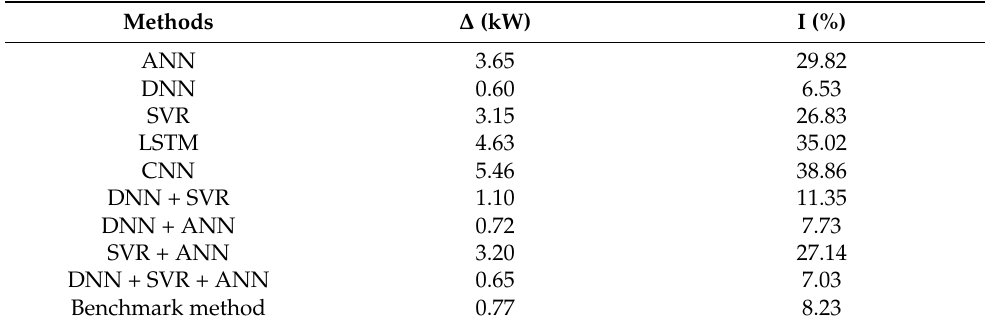
Table 10. The improvement of the proposed method compared to the single, combination, and benchmark